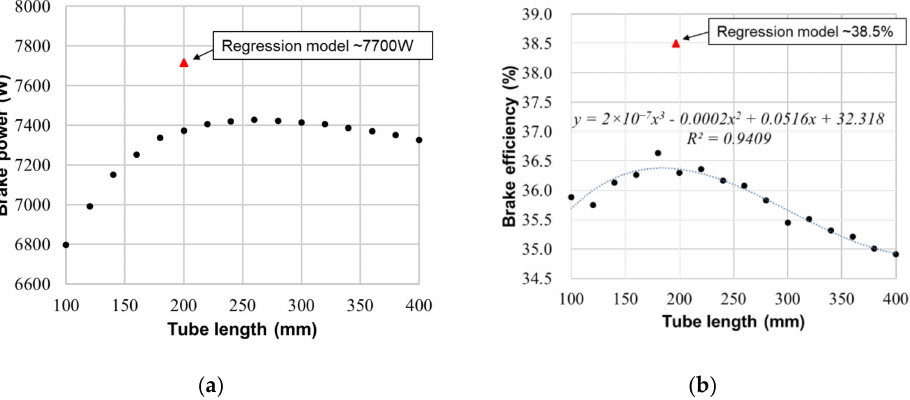
Figure 12. Predicted ( a ) brake power and ( b ) efficiency with respect to tube length changes when the tube inner diameter is 8.5 mm and the number of tubes is 39 through the iQSF